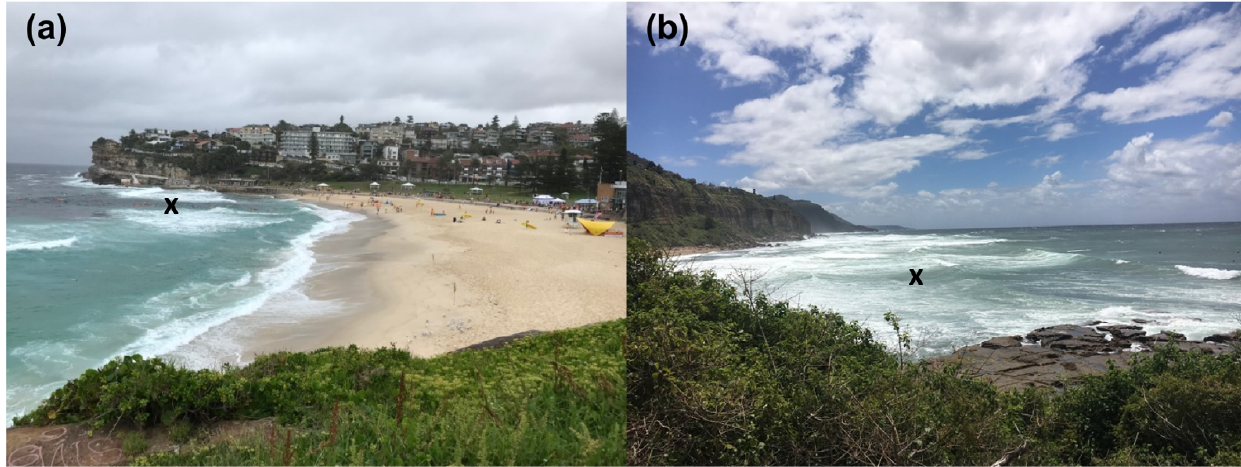
Figure 3. Images from (a) Bronte Beach and (b) Coalcliff Beach in New South Wales, Australia, were used for checking participants’ ability to identify rip currents. These were chosen as they contained rip channels that presented visually as darker areas between breaking waves, which is similar to the rip current present at the study site during the surveys. Participants were asked to mark with an “x” any area they thought there was a rip; an example identification is shown above. Photograph credits: (a) Walkingmaps.com.au; (b) Rob Brander. Table 4. Self-reported swimming competency, broken down by the percentage of male and female respondents. The value in brackets was an assigned numerical value to aid the statistical analysis of responses. Question Response (Value) Female Male respondents (% ) respondents (%) Rate your swimming competency. Poor